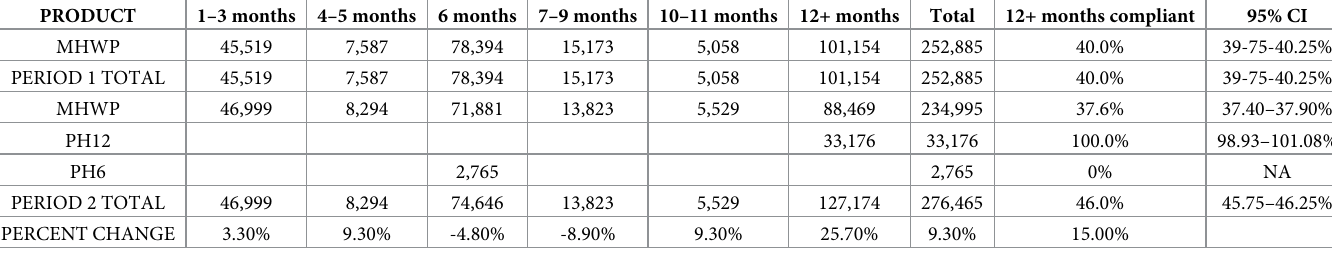
Table 4. Patient level comparison of doses purchased Period 1 vs Period 2. New PH 12 Users.